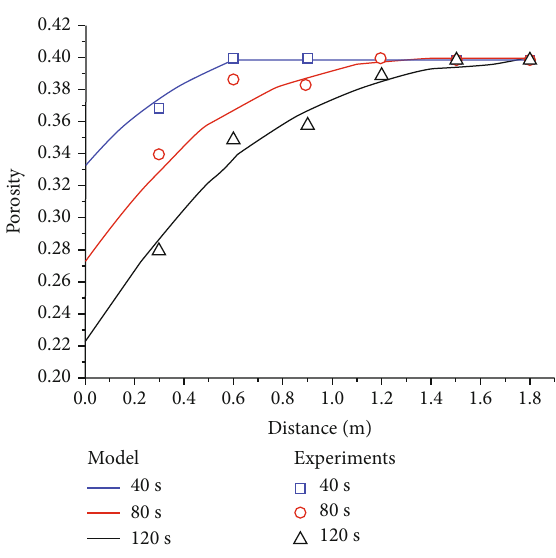
Figure 11: The spatial and temporal variation of porosity (Q= 2.85L/min, WCR =1.5).